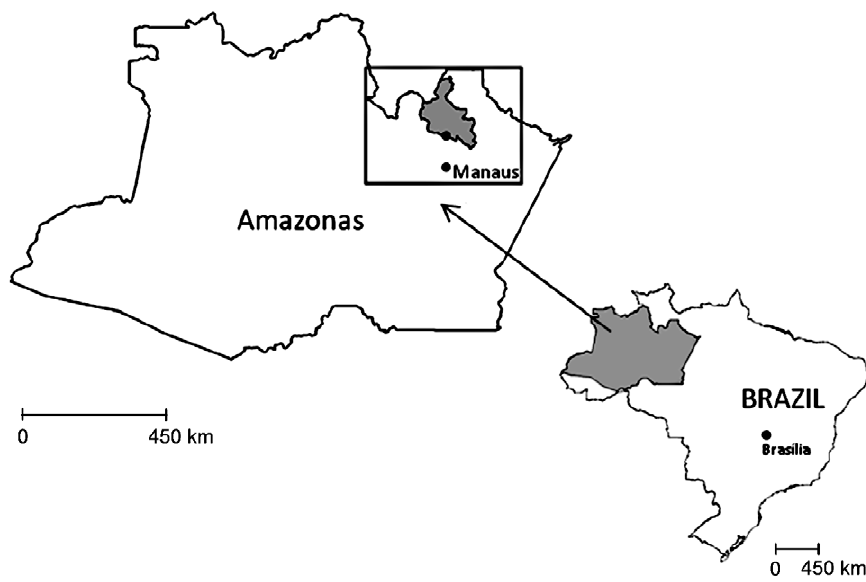
Figure 1. Map of the State of Amazonas and study area (area in the inset).